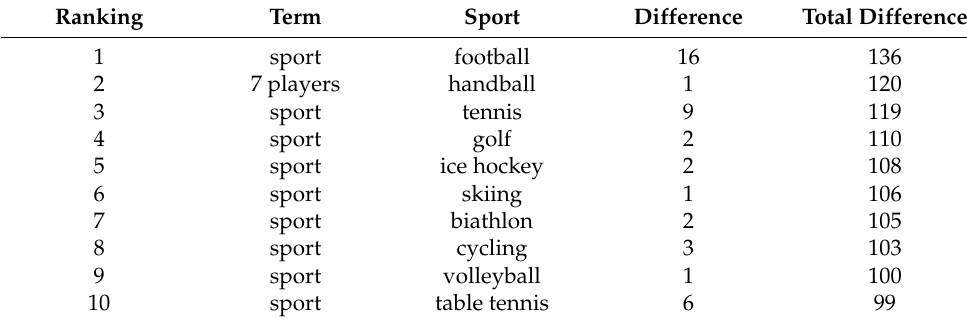
Table 1. Google Trends searches—Germany, data from